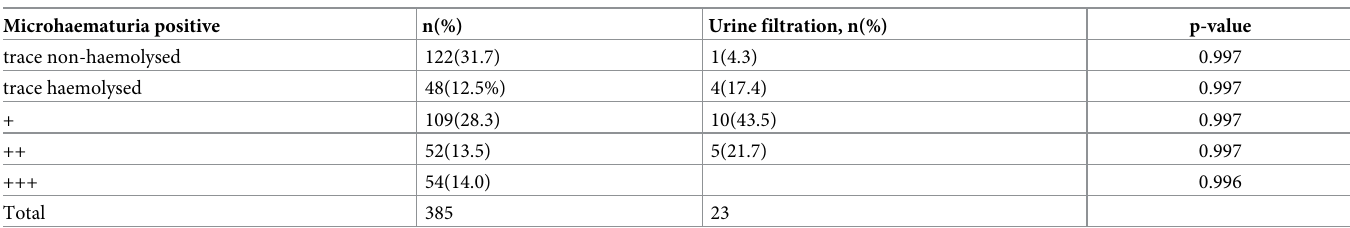
Table 2. Association of urine filtration and